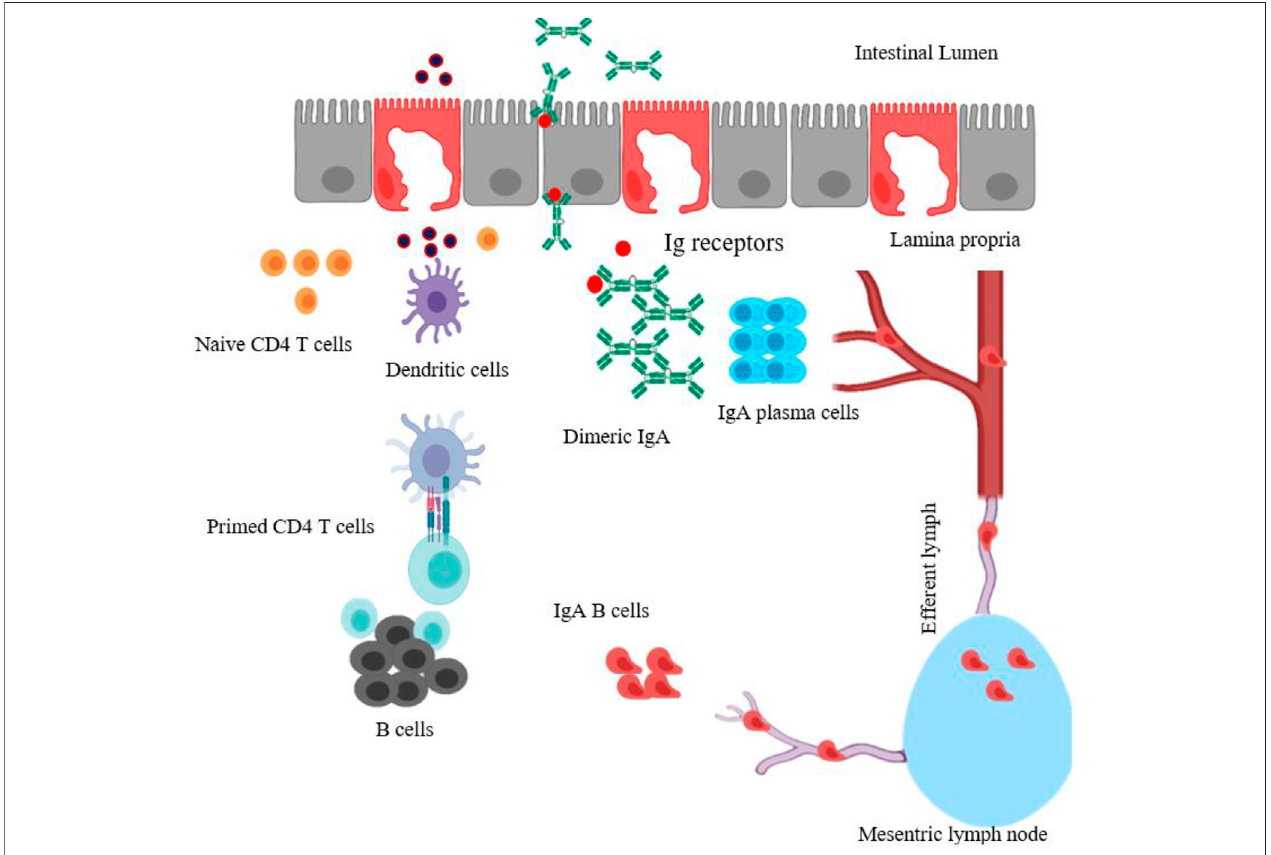
FIGURE1| Schematicdiagramofmucosal immuneinductiontogenerateT-cell-dependentIgAproduction. Theparticulateantigens inintestinal lumen aremoved across the intestinal epithelium barrier by sampling M cells, transcytosed and presented to DCs. The antigen-loaded DCs (activated DCs) could travel and prime naïve CD4 T cells in Peyer ’ s patches. Primed CD4 T cells then activate B cells, which undergo isotype switching, thus generating antigen-speci fi c IgA + B cells. These IgA + B cells leave the Peyer ’ s patches through the afferent lymph system to mesenteric lymph node, enter the blood circulation and reach effector sites in the lamina propria, mature, and become IgAproducing-plasma B cells. The dimeric or polymericIgA binds toIg receptors expressed on the basolateral surface of epithelial cells to form SIgA. The fi gure is made with biorender (https://biorender.com/).